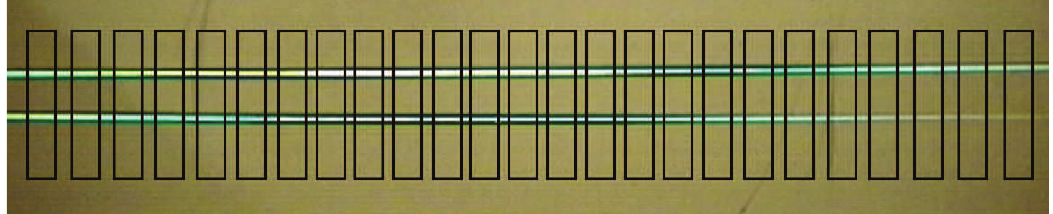
Figure 8. The segmentation process applied to a single video frame.